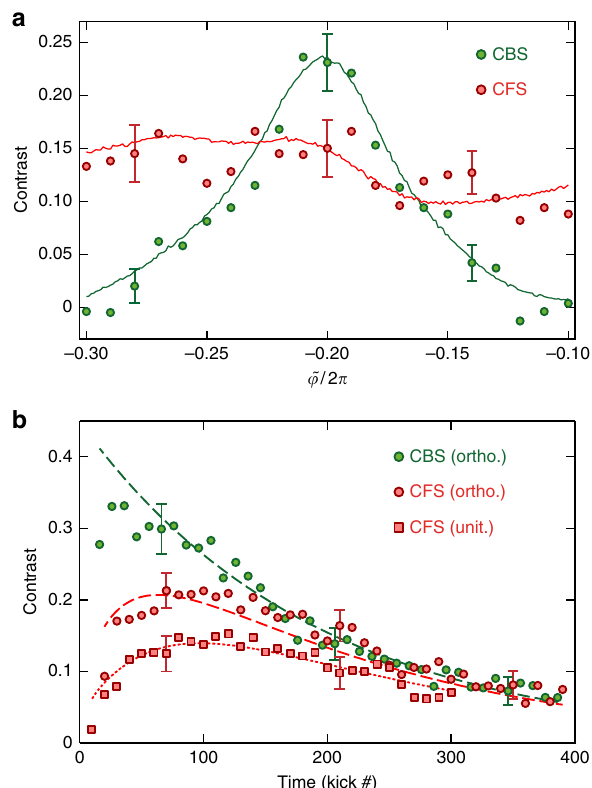
Fig. 3 Symmetry-breaking and temporal characteristics of the CBS and CFS peaks. a The experimental CBS (green) and CFS (red) contrasts were measured vs. the parameter ~ φ , which controls the symmetry class. The data are taken at t = 70 kicks, when the CFS contrast approaches that of the CBS. The CBS contrast is maximum at ~ φ ¼ (cid:2) 2 π = 5, where there is a perfect PT -symmetry. When ~ φ varies, the CBS contrast decreases, and eventually vanishes when the symmetry is completely broken. Contrary to CBS, the CFS contrast is almost insensitive to the value of ~ φ . The error bars indicate the typical experimental uncertainty. The solid lines are ab initio numerical simulations 33 using experimentally measured parameters. b The time evolutions of the CBS (orthogonal, green) and CFS (orthogonal — red circles, and unitary — red squares) contrasts corresponding to Fig. 2. The CBS follows an exponential decay (dashed green line, fi t), due to decoherence, with a fi tted time constant t dec ≈ 190. The CFS contrasts are fi tted using the equations in refs. 22 and 35 (red lines) with decoherence effects included. This yields t loc ≈ 40 in the unitary class and t loc ≈ 37 in the orthogonal